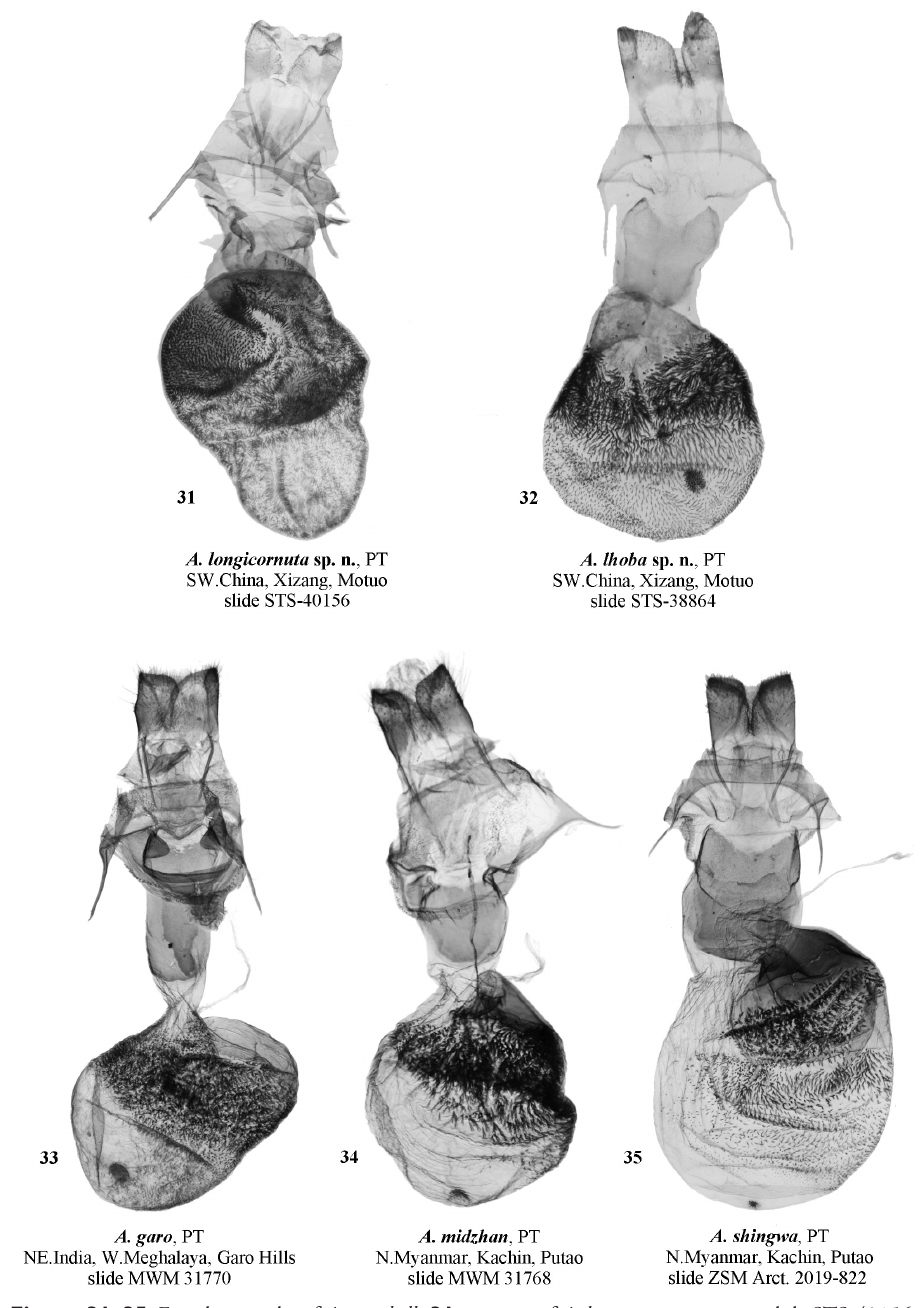
Figure. 31–35. Female genitalia of Ammathella 31 paratype of A. longicornuta sp. nov., slide STS-40156, SW China (TAAHU) 32 paratype of A. lhoba sp. nov., slide STS-38864, SW China (TAAHU) 33 para- type of A. garo , slide MWM 31770, NE India (MWM/ZSM) 34 paratype of A. midzhan , slide MWM 31768, N Myanmar (MWM/ZSM) 35 paratype of A. shingwa , ZSM Arct. 2019–822 Volynkin, N My- anmar